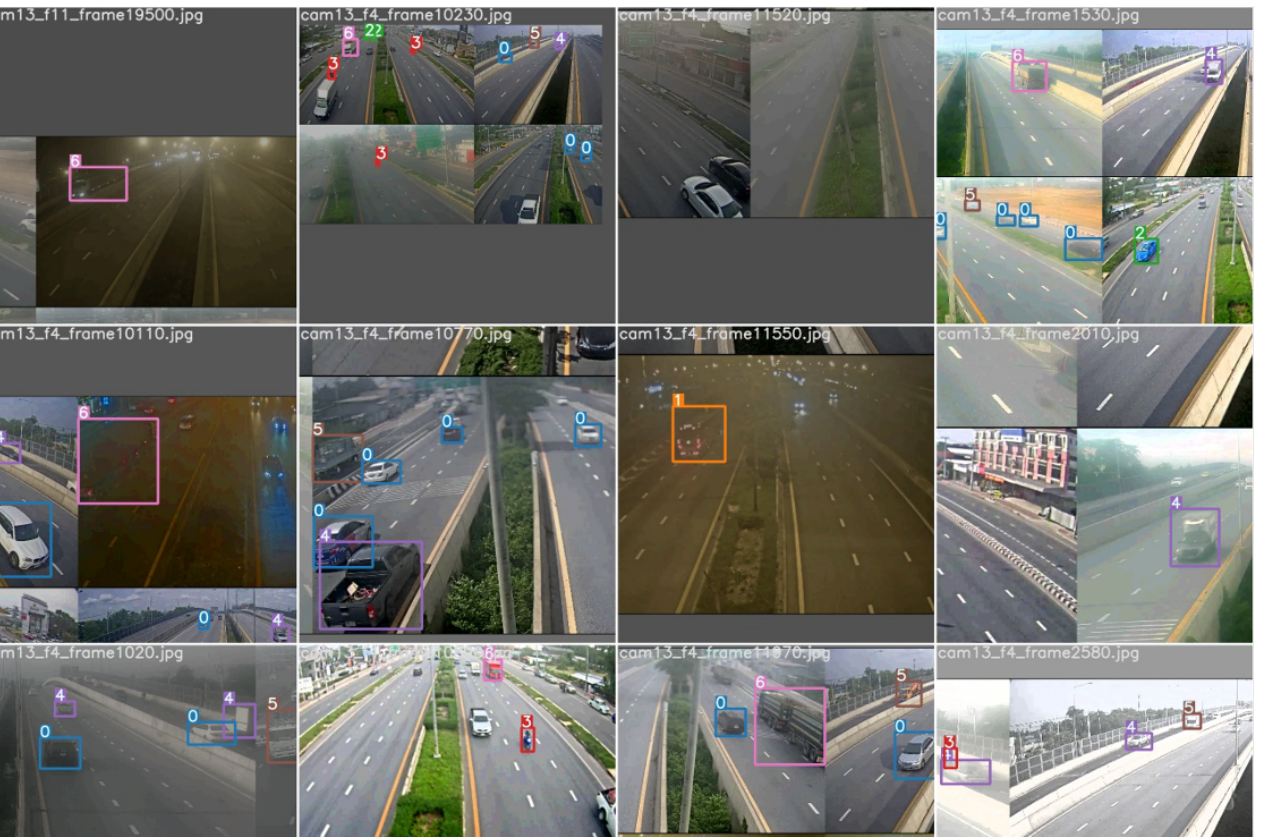
Figure 6. Sample results produced by the trained YOLOv5l model with the test images of TR1. The classes are predicted from 0 to 6, for car, bus, taxi, bike, pickup, truck, and trailer,